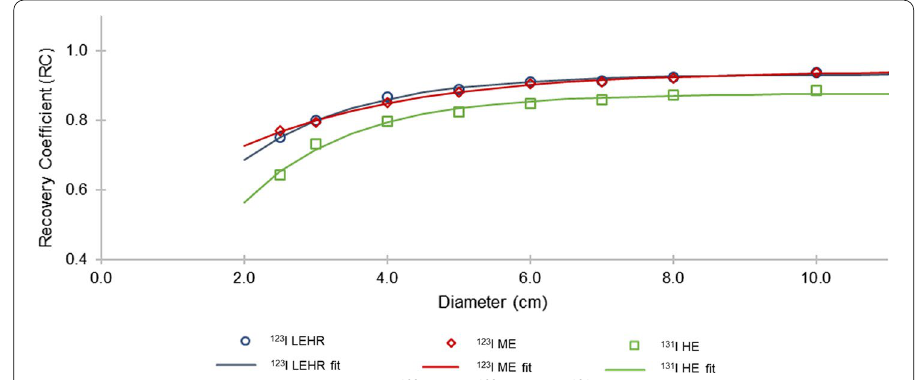
Fig. 5 RC as a function of sphere diameter for 123 I LEHR, 123 I ME and 131 I HE, with the solid lines showing the fitted functions